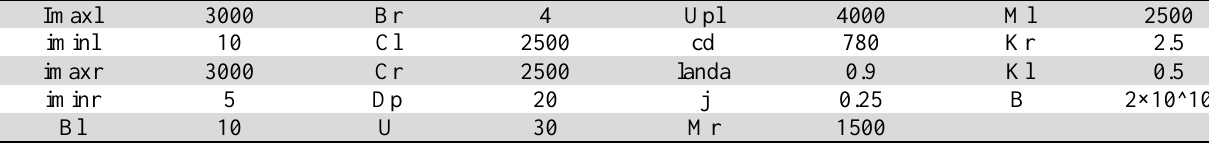
Parameters of examples with five periods